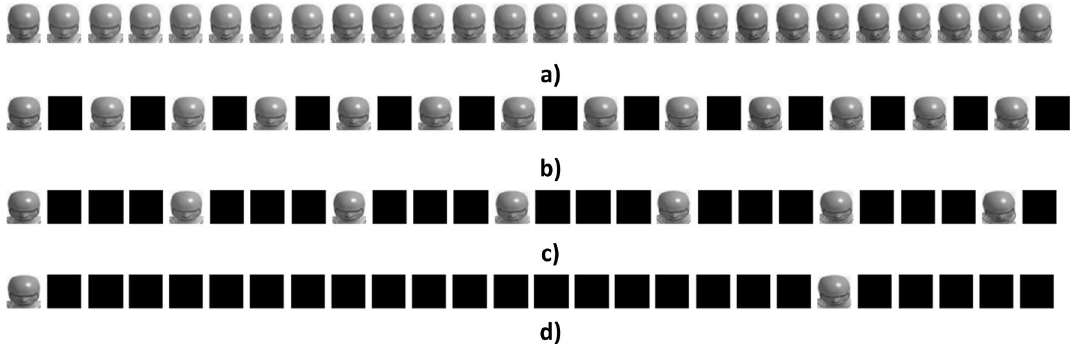
Figure 5. Input sequence of Images for ( a ) 500 fps, ( b ) 250 fps, ( c ) 125 fps, and ( d ) 25 fps. Image sequences shown for first 50 ms only for visualization purposes.